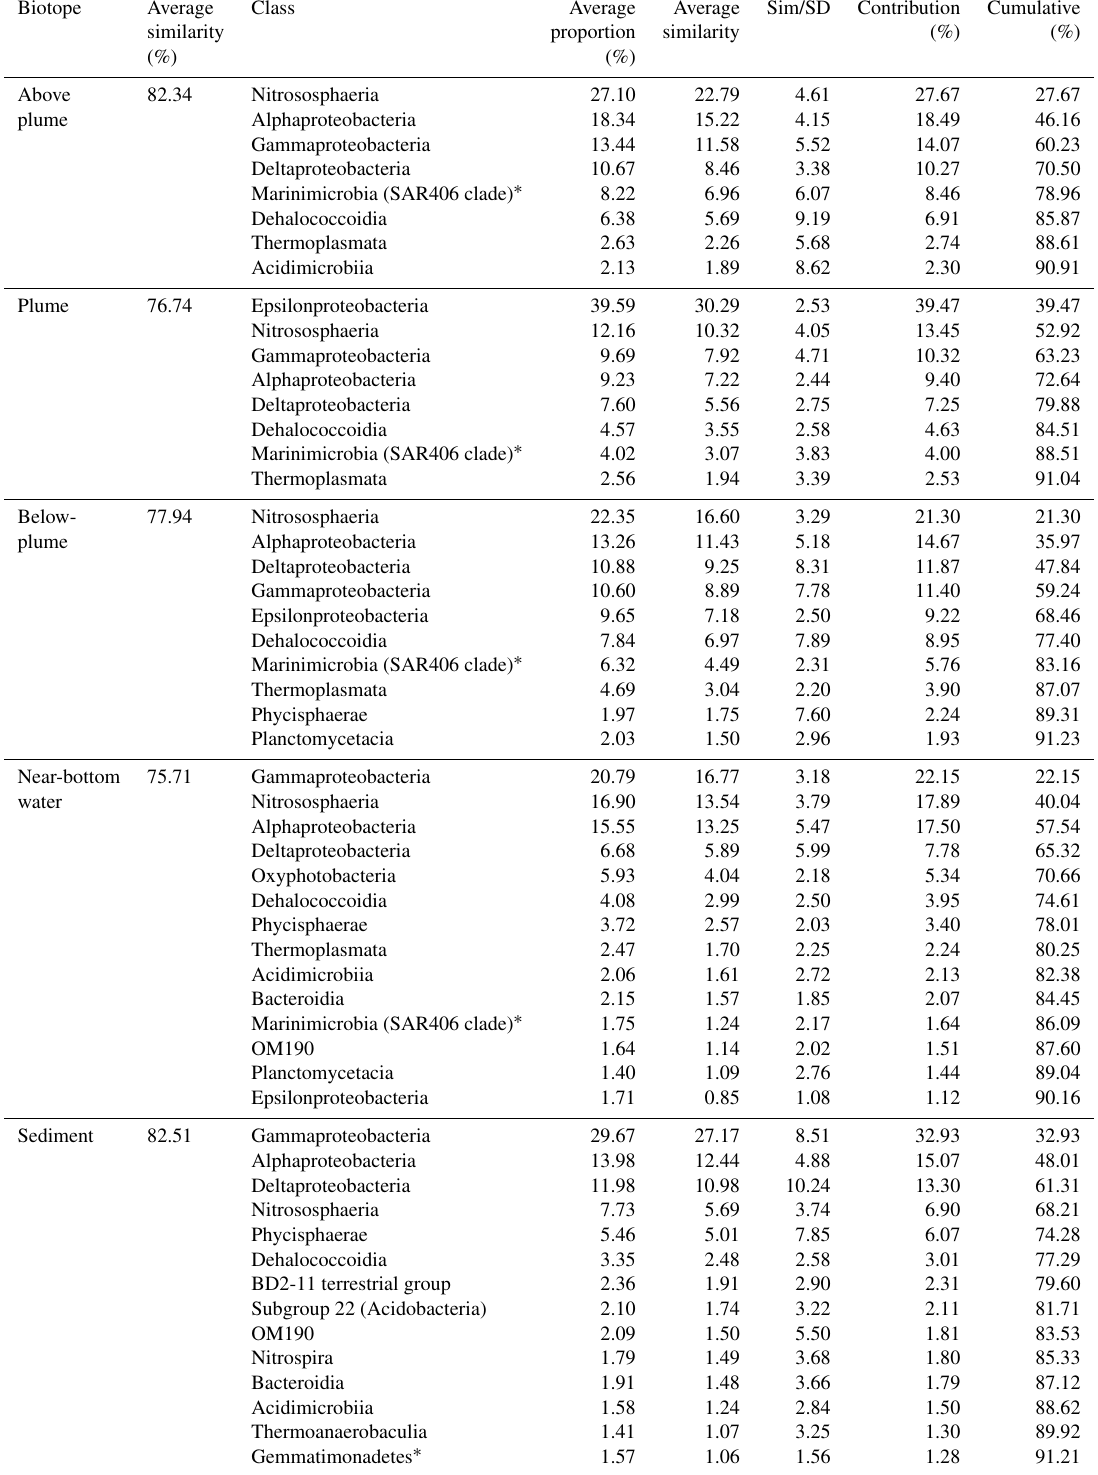
Table 3. SIMPER similarity results of each biotope at class level. Biotope